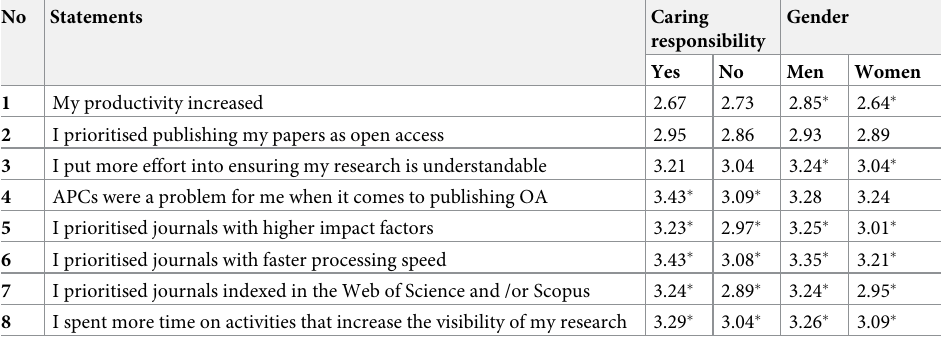
Table 9. Mean value of the agreement with statements by gender and caring